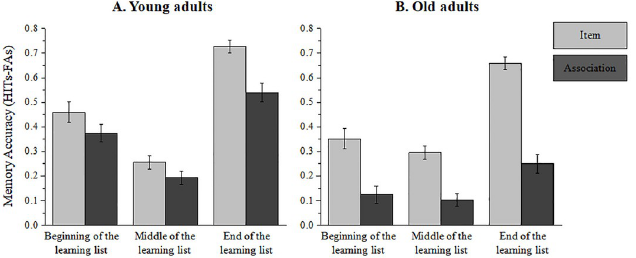
Fig 2. Memory accuracy as a function of age (a = young, b = old), SSP (beginning, middle and end of the learning list) and test (item/association). Error bars represent the standard error of the mean.